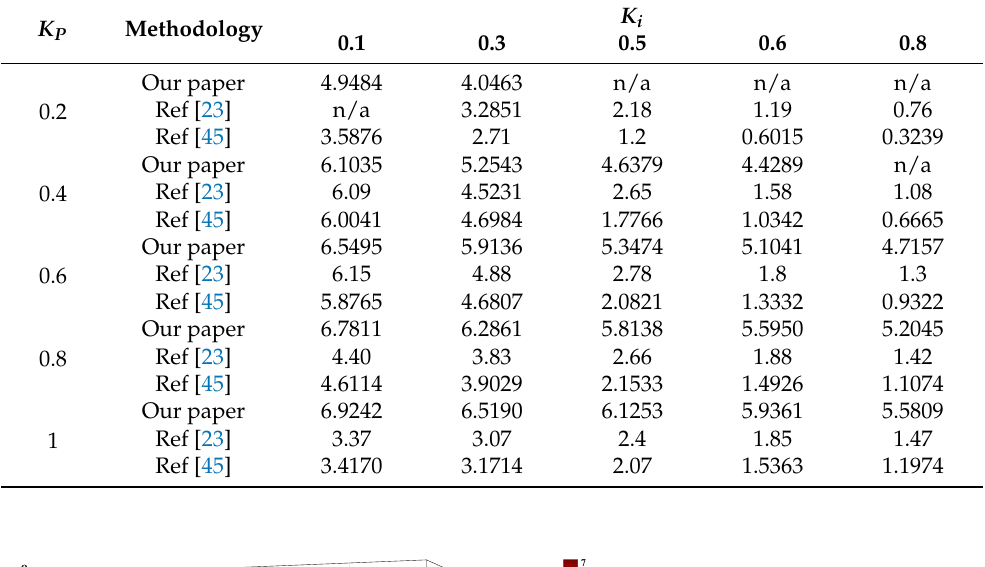
Table 6. Comparison of the maximum permitted delay for an EV aggregator with α 1 = 0.2 from